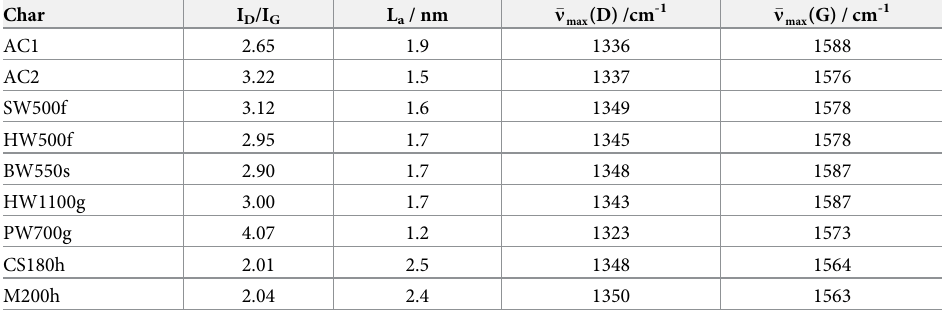
Table 9. Ratio of the heights of D and G peak (ID/IG), crystallite size calculated from ID/IG, and the wavenum- bers � n of peak maxima of the Raman spectra of the max